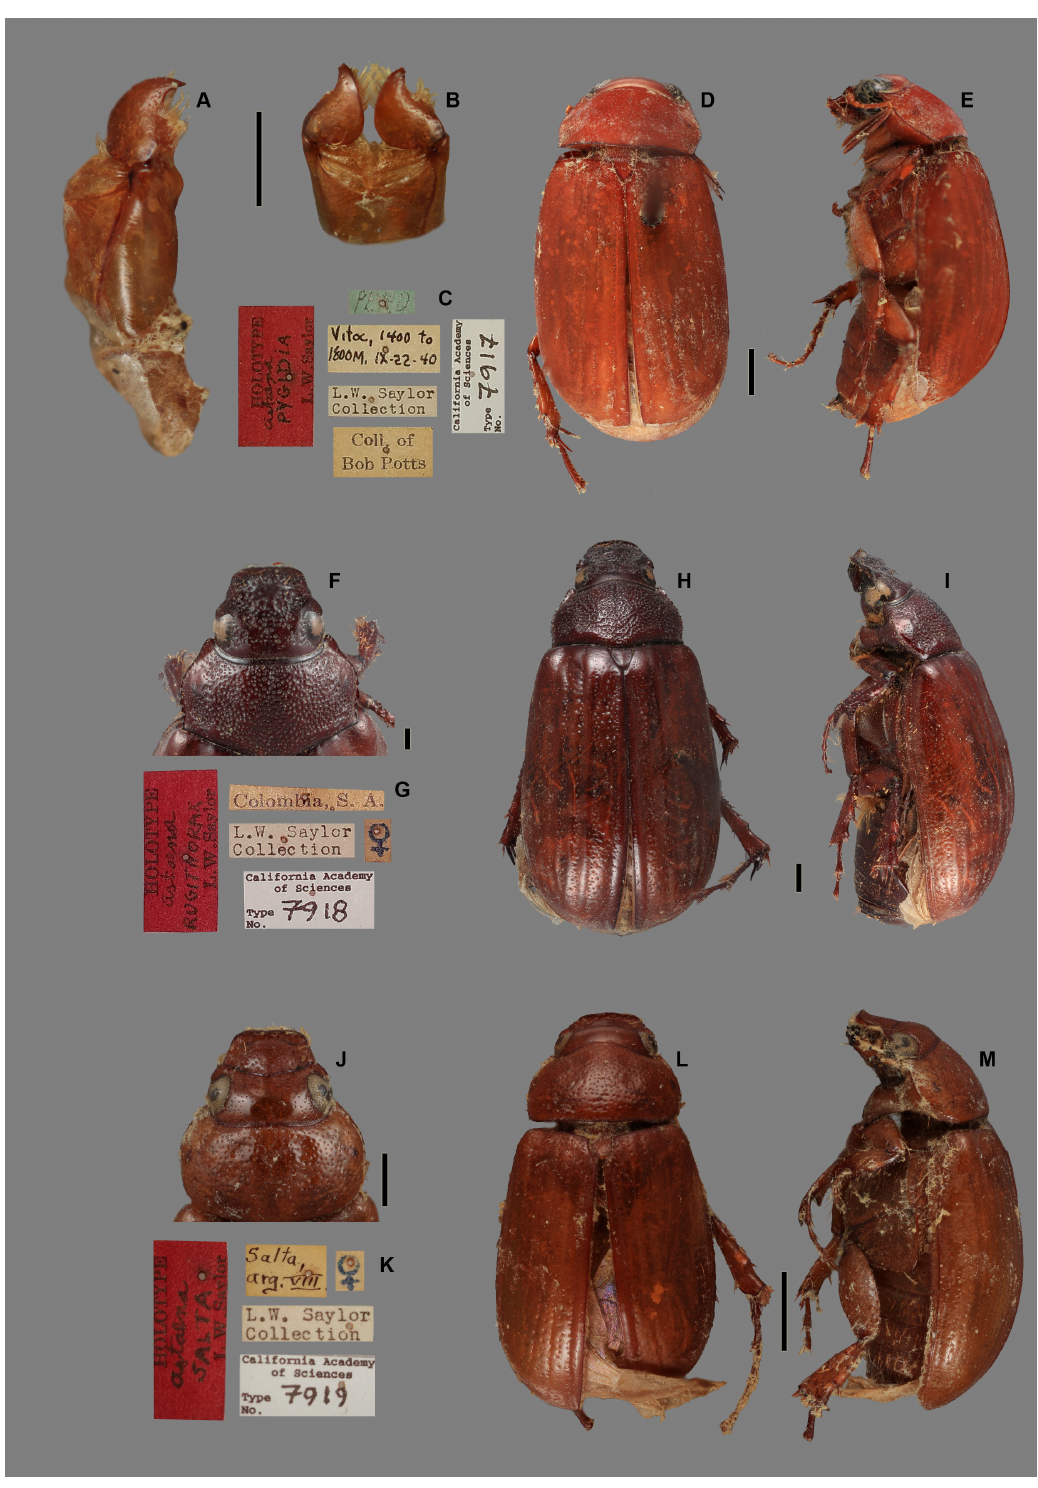
Fig. 4. A–E . Astaena pygidia Saylor, 1946, holotype, ♂ (Type No. 7917; CAS). – F–I . A. rugithorax Saylor, 1946, holotype, ♀ (Type No. 7918; CAS). – J–M . A. salta Saylor, 1946, holotype, ♀ (Type No. 7919; CAS). A . Aedeagus, lateral view. B . Parameres, dorsal view. C, G, K . Labels. D, H, L . Habitus, dorsal view. E, I, M . Habitus, lateral view. F, J . Head and pronotum, dorsal view. Scale bars: A–B, F, J = 0.5 mm; D–E, H–I, L–M = 1